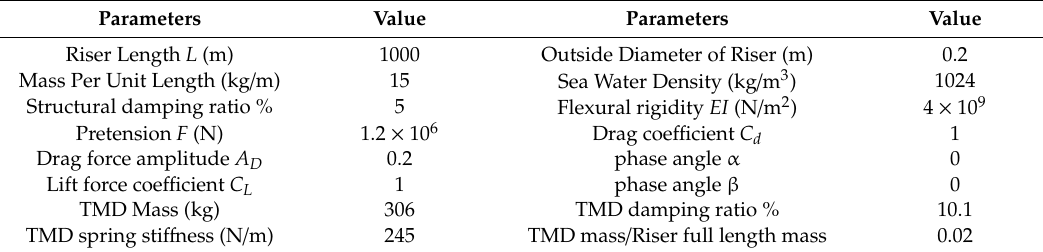
Table 1. Risers and TMD parameter table.